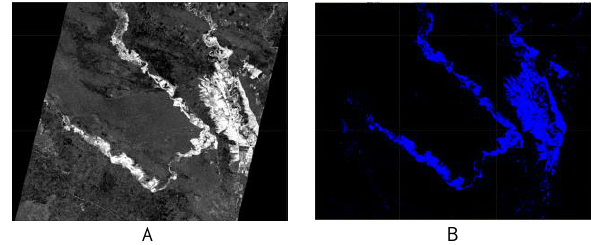
Figure 4. Initial flood maps; A) difference image; B)